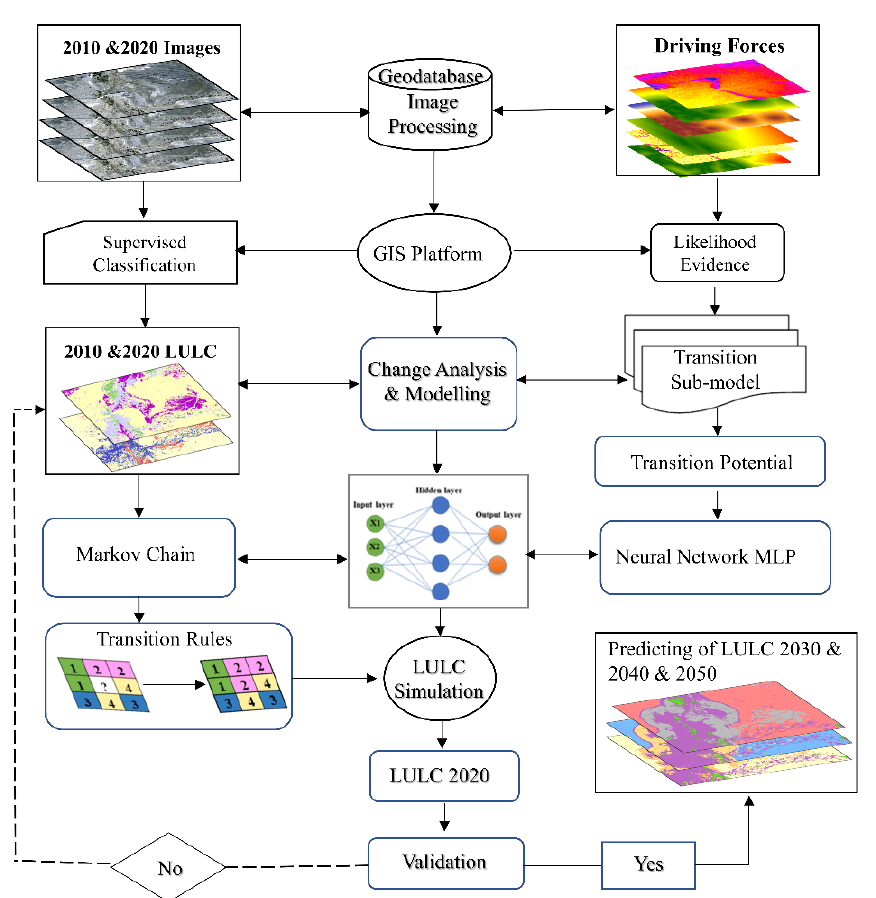
Figure 2. Flowchart showing the methodological framework for predicting LULC changes in the study area.